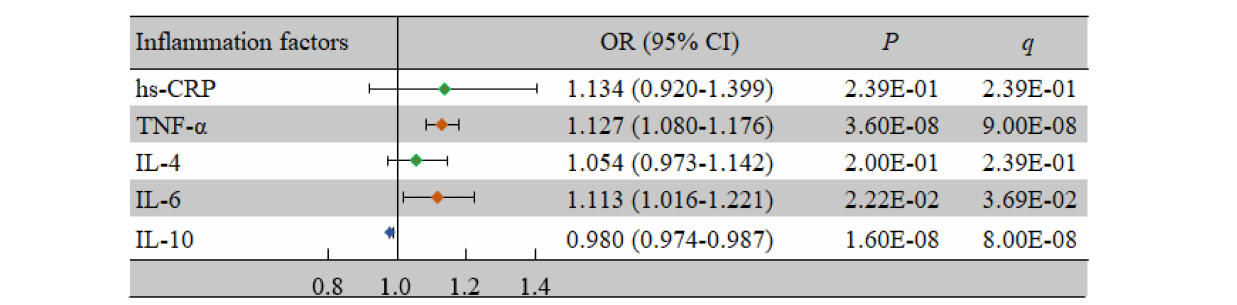
FIGURE 1 | Associations of inflammatory factors and VCI as determined by multivariate logistic regression analyses. P < 0.05 was considered statistically significant using logistic regression analysis; q < 0.05: significant after correction using FDR. The multivariate logistic regression analyses were performed after adjusting for age, BMI, education, income, smoking, drinking, salt intake habit, hypertension, hyperlipidemia, and diabetes mellitus. BMI, body mass index; CI, confidence interval; FDR, false discovery rate; hs-CRP, high-sensitivity C-reactive protein; IL-4, interleukin-4; IL-6, interleukin-6; IL-10, interleukin-10; OR, odds ratio; TNF- α , tumor necrosis factor-alpha; VCI, vascular cognitive